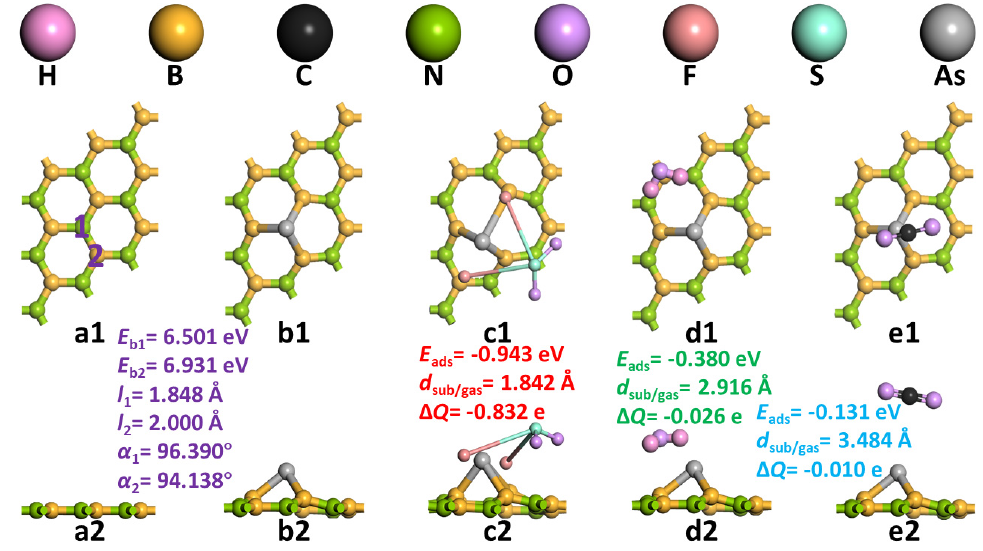
Figure 1. The geometric structures of ( a1 , a2 ) h − BN monolayer, ( b1 , b2 ) As − BN monolayer, ( c1 , c2 ) SO 2 F 2 adsorption system, ( d1 , d2 ) H 2 O adsorption system, ( e1 , e2 ) CO 2 adsorption system.